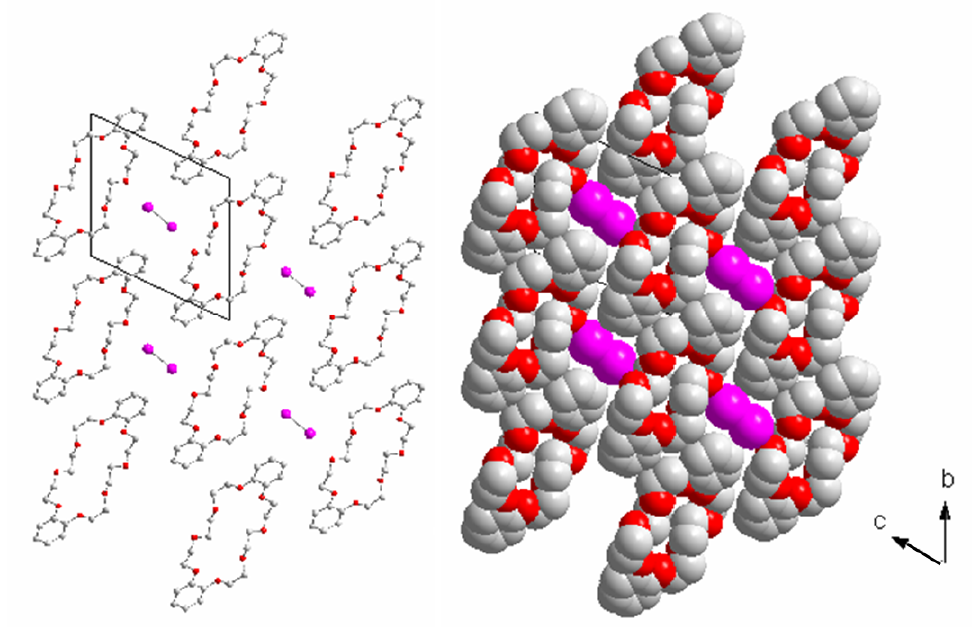
Figure 1. Perspective view of the crystal structure of (I ball-and-stick and space-filling